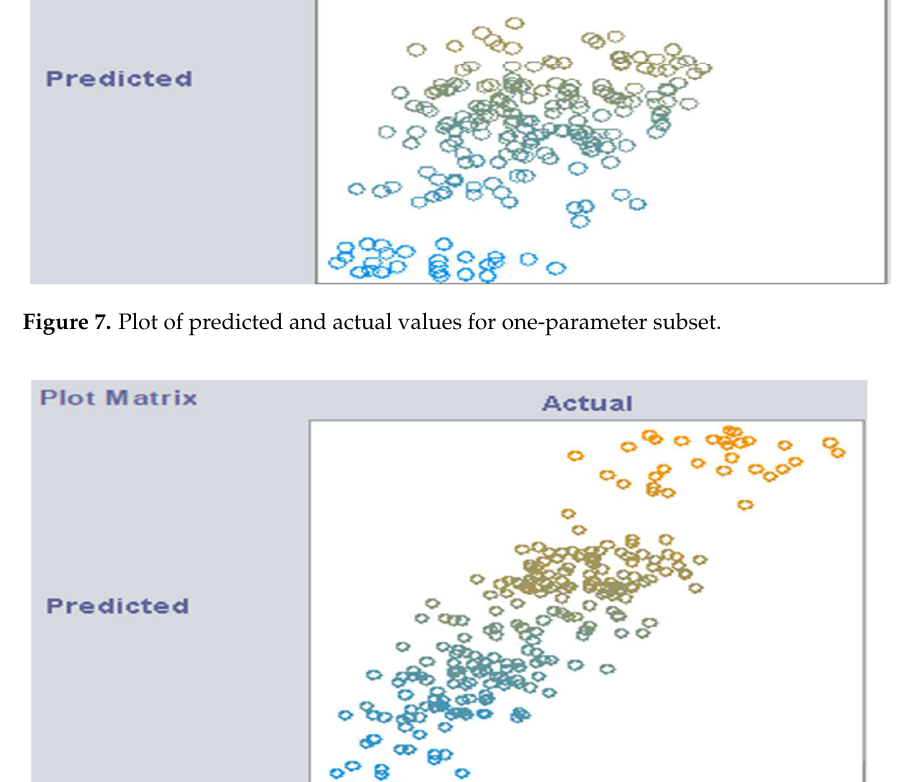
Figure 8. Plot of predicted and actual values for two-parameter subset.